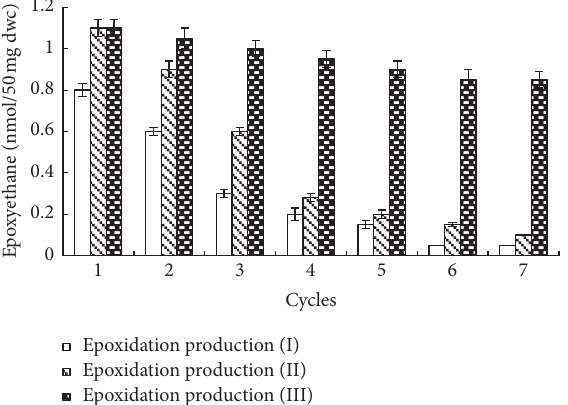
Figure 6: The repetitive batch epoxidation experiments with differ- ent methanol concentrations. (I) 0mmol/L methanol; (II) 1mmol/L methanol; (III) 3 mmol/L methanol.